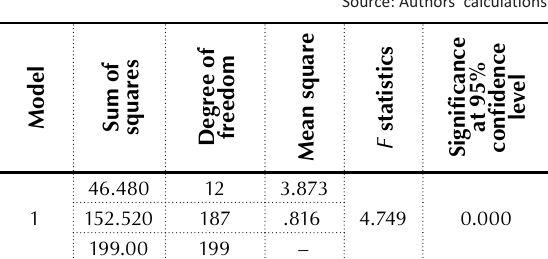
Table 8. Multiple regression